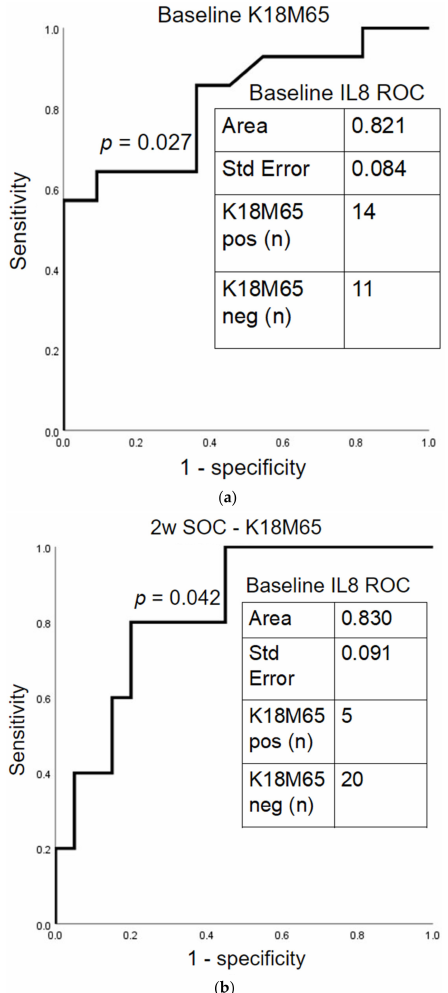
Figure 6. Theragnostic prediction efficacy of 2-week inpatient standard of care in alcohol use disorder patients for improvement in K18M65 in Gr.2. ( a ) True positivity of baseline IL-8 response in predicting K18M65 improvement to normal levels using AUROC Analyses with baseline; ( b ) and after 2 weeks of standard of care. K18M65 as 500 IU/L as normal was used as the primary factor.